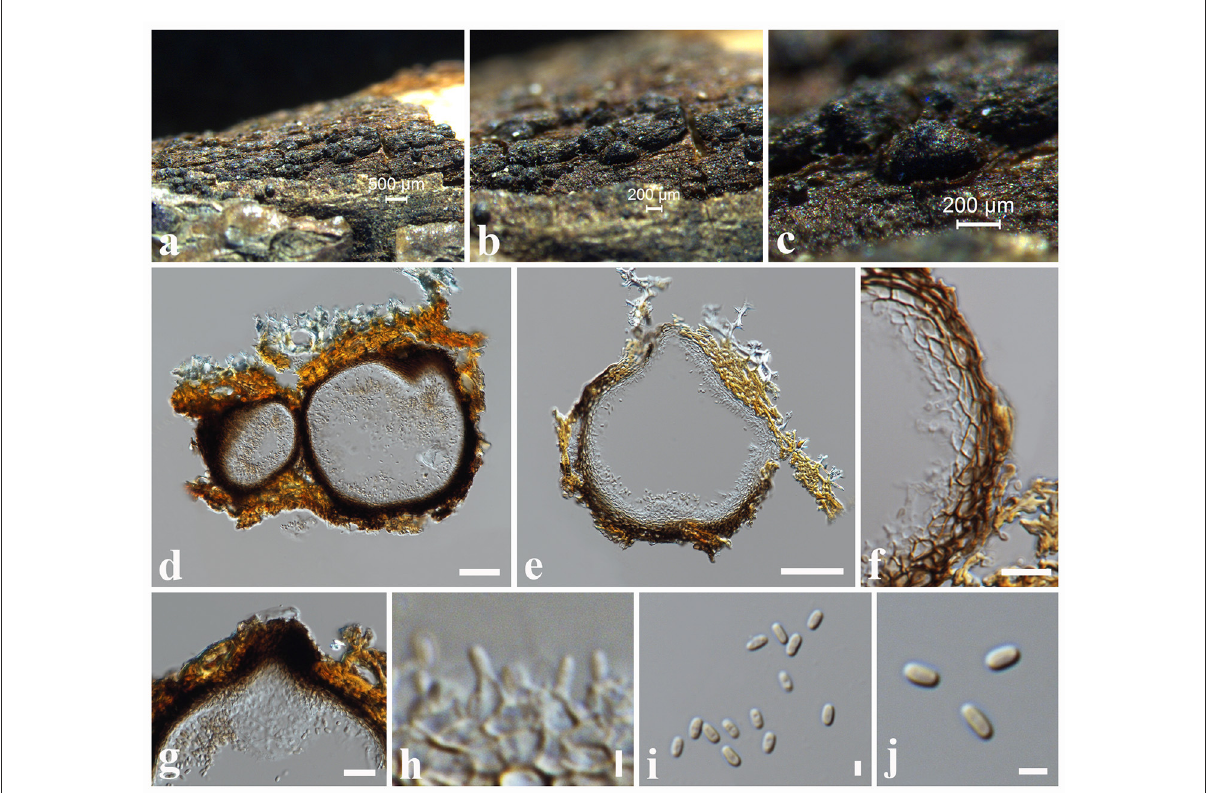
FIGURE6 Paraconiothyrium brasiliense (MFLU 18-2649, new host record): (a,b) Conidiomata on a dead twig of Magnolia sp. (c) Close-up of conidiomata. (d,e) Sections through conidiomata. (f) Conidiomatal wall. (g) Sections through conidiomata showing neck region. (h) Conidiogenous cells and developing conidia. (i,j) Conidia. Scale bars: (a) = 500 µ m, (b,c) = 200 µ m, (d,e) = 50 µ m, (f) = 10 µ m, (g) = 20 µ m, (h–j) = 2 µ m.